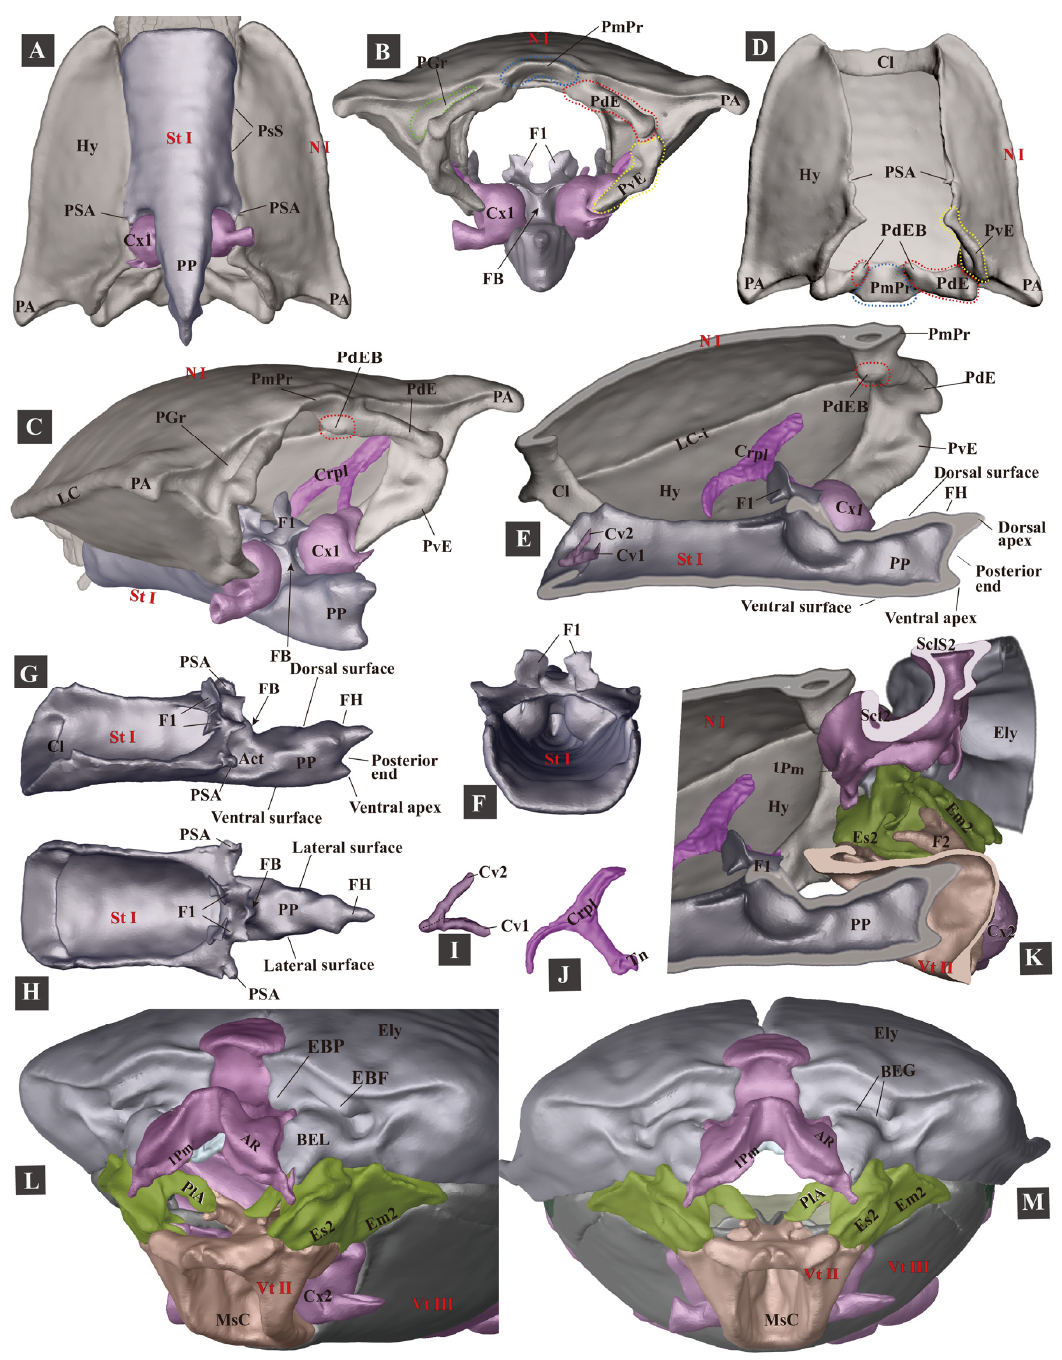
Figure 4. Three-dimensional reconstructions of the pro- and mesothoracic skeleton of Campsosternus auratus . For abbreviations, see Section 2 ‘Materials and Methods’. ( A – C ) ventral, caudal, and posterolateral views of the prothorax. ( D ) ventral view of the pronotum. ( E ) mesal view of the prothorax cut in sagittal plane. ( F – H ) frontal, lateral, and dorsal views of the prosternum. ( I ) the right cervical sclerites, dorsal view, with the anterior part facing left. ( J ) cryptopleuron and trochantin, mesal view. ( K ) mesal view of mesothorax cut in the sagittal plane. ( L , M ) anterolateral and frontal views of the